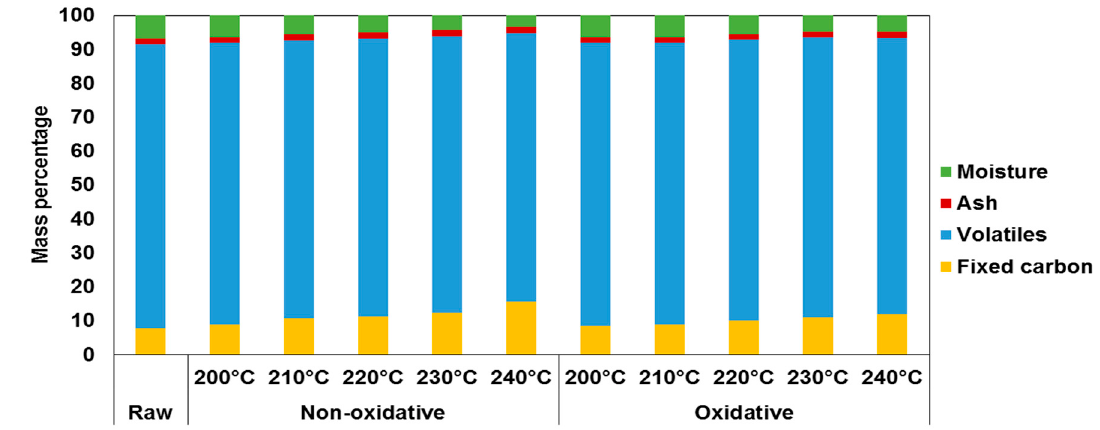
Figure 1. Proximate analysis of torrefied SRCP.